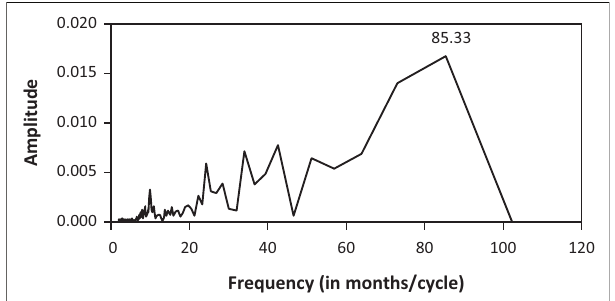
FIGURE 7: Frequency spectrum for South African small house price gap.